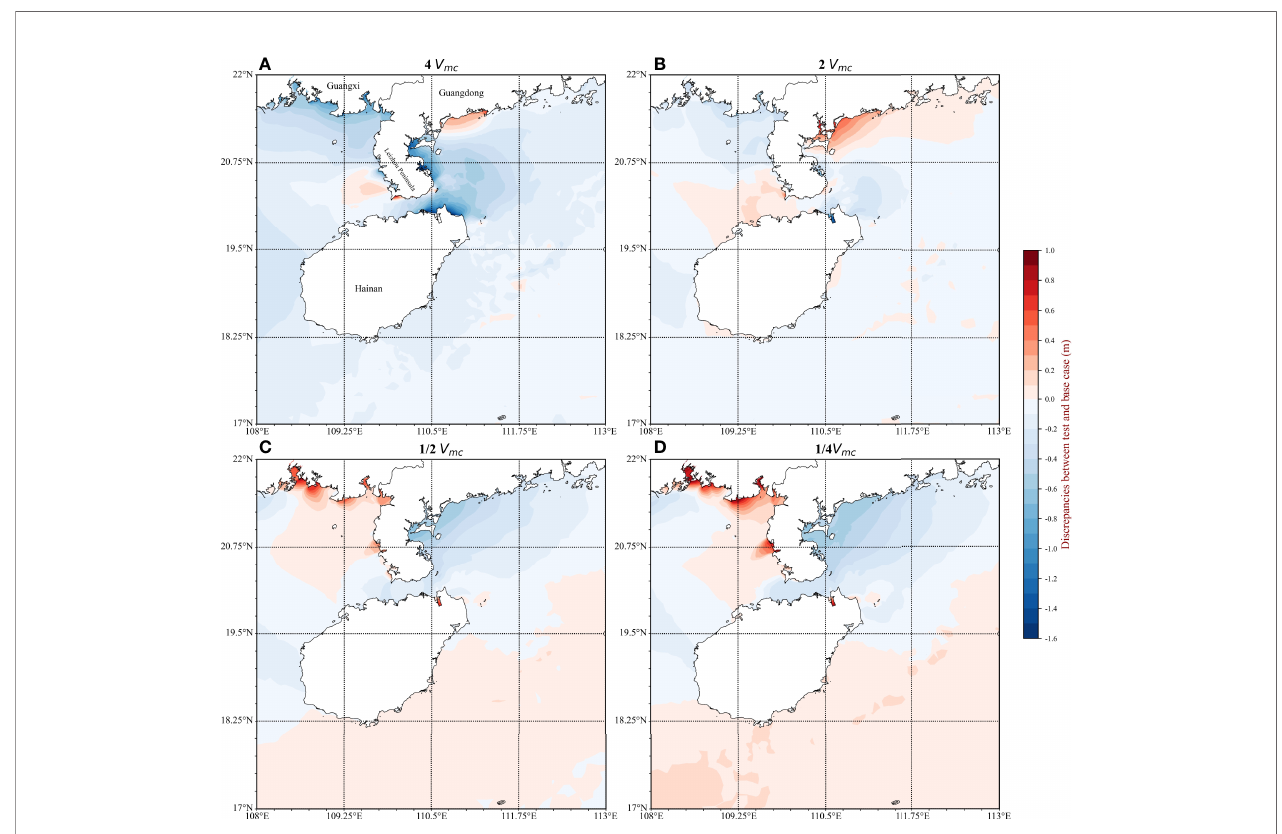
FIGURE 9 | The discrepancies of peak surge heights between (A) Test 6 and Test 5, (B) Test 7 and Test 5, (C) Test 8 and Test 5, and (D) Test 9 and Test